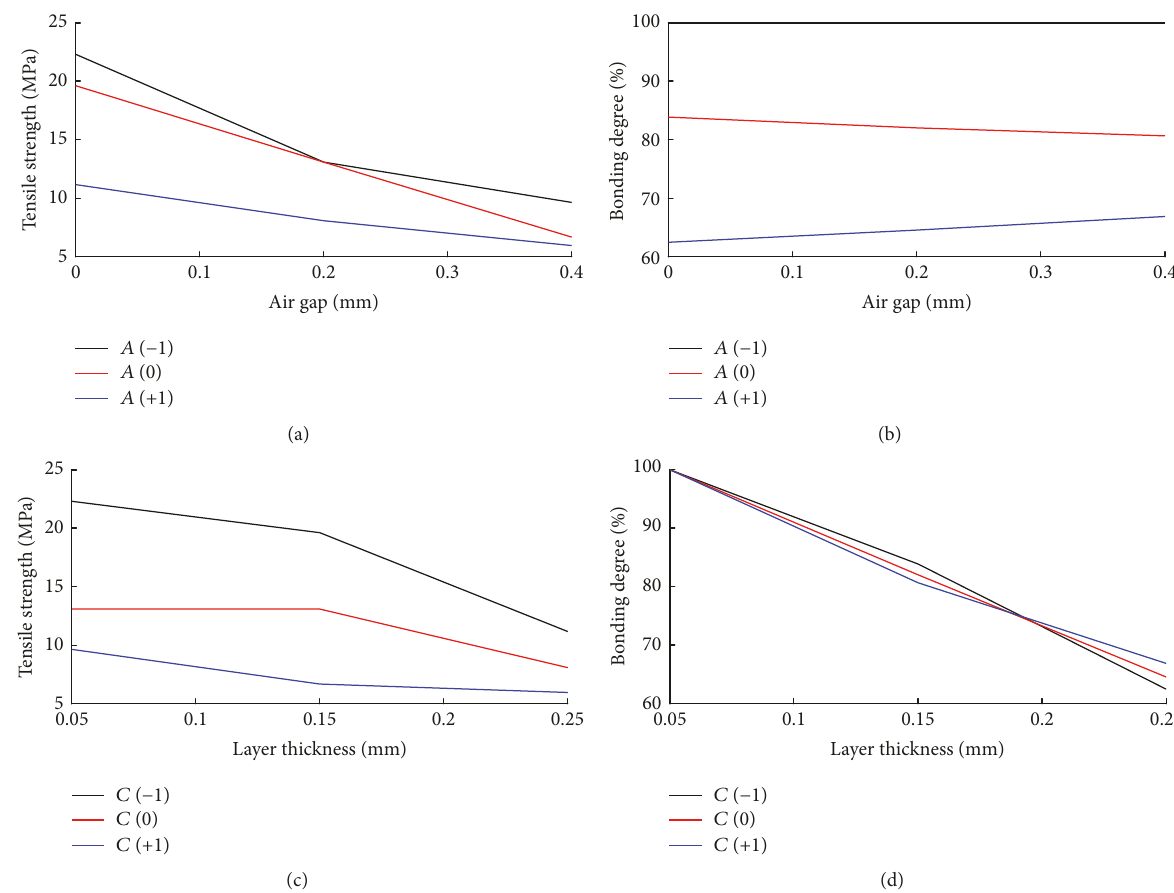
Figure 6: The change of tensile strength and bonding degree caused by air gap and layer thickness.